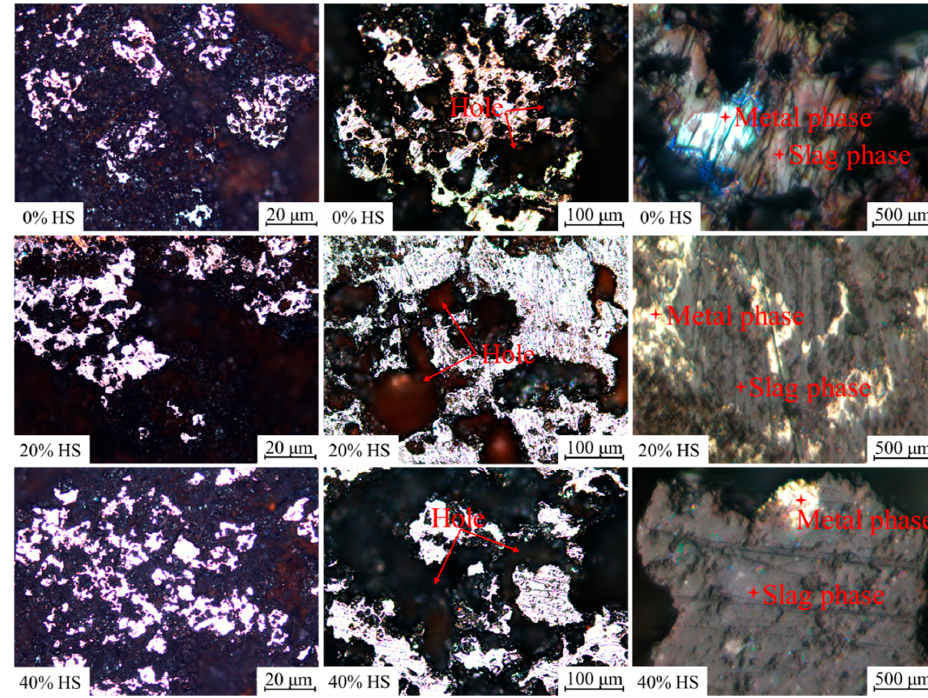
Figure 16. The microscopic morphology of oxidized pellets reduced at 900 °C for 3 h.